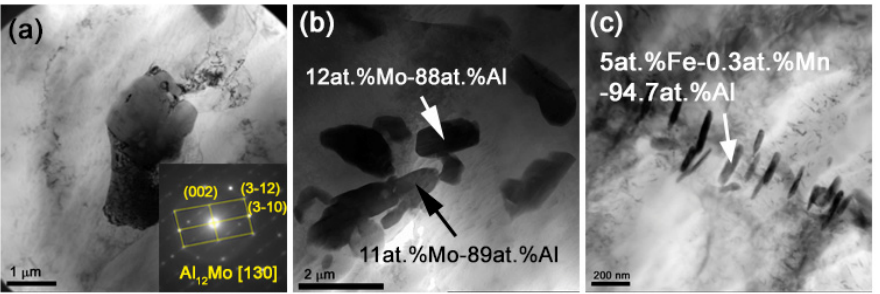
Figure 12. TEM bright-field images of zone 2 AA5154/Mo microstructures obtained with 0.9 g/layer ( a ) and 1.2 g/layer ( b , c ) Mo.